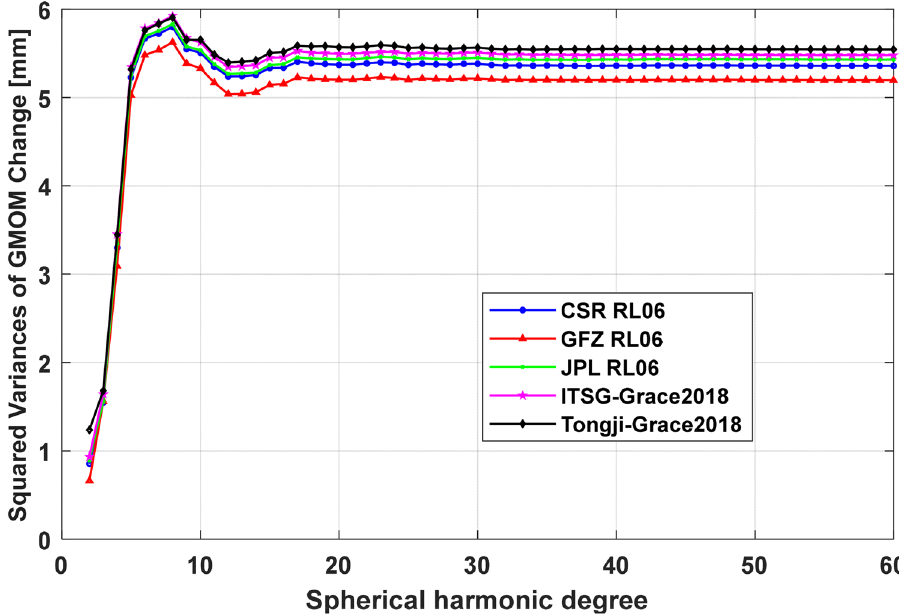
Figure 6. The squared variance of GMOM change series derived from different truncated degrees and orders with five GRACE solutions except for C 20 term.